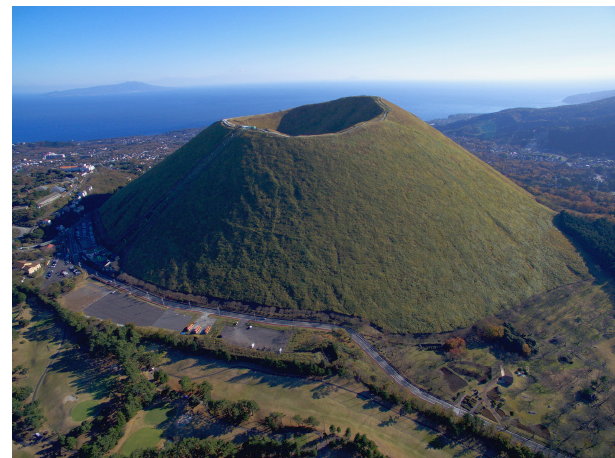
Figure 1. Photograph of the Izu–Omuroyama scoria cone from the northwest, taken by an unmanned aerial vehicle (Koyama,